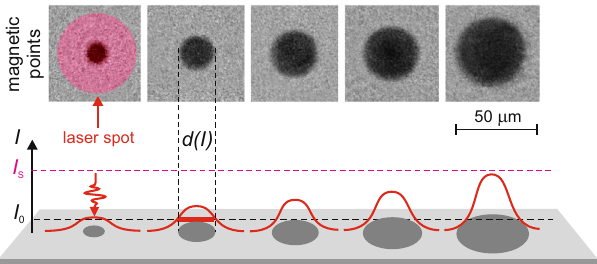
Fig. 7 | Writing single magnetic points using AOS. The images of reversible writing by AOS magnetic points with a different pump fl uence from left to right show: 12mJcm − 2 ; 14.2mJcm − 2 ; 15.6mJcm − 2 ; 17mJcm − 2 and 20mJcm − 2 . The hor- izontal dashed lines indicate the switching threshold and saturation of the laser pulse intensity I . The laser spot also denotes the diffraction limit of the optical con fi guration of writing process.